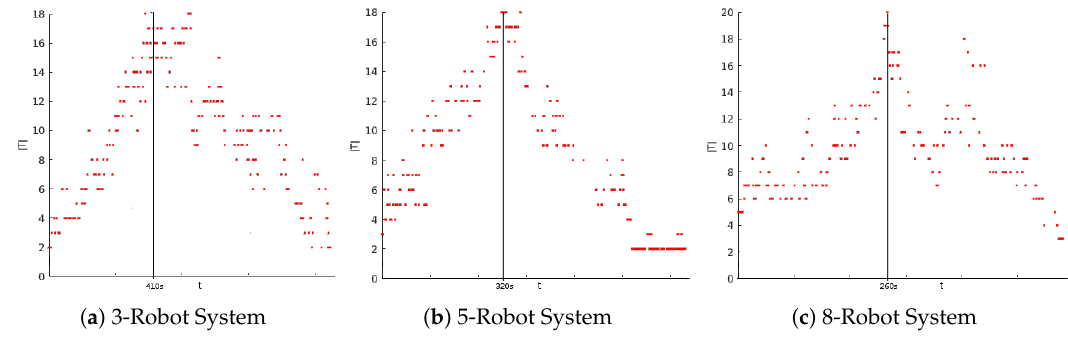
over time for different sized multi-robot systems. T u | |